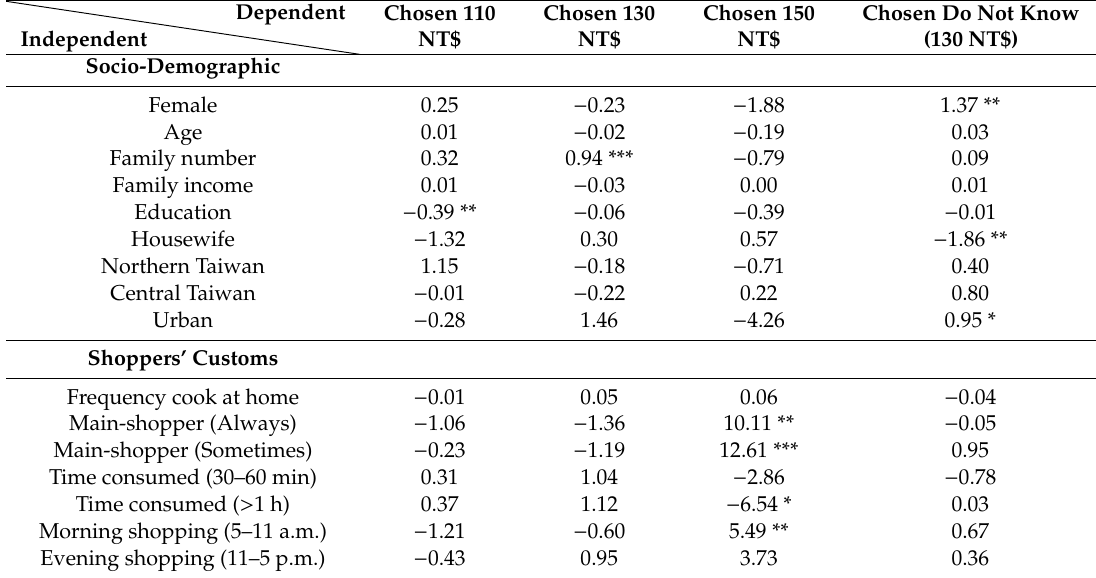
Table 3. The estimation of WTP for nutrition